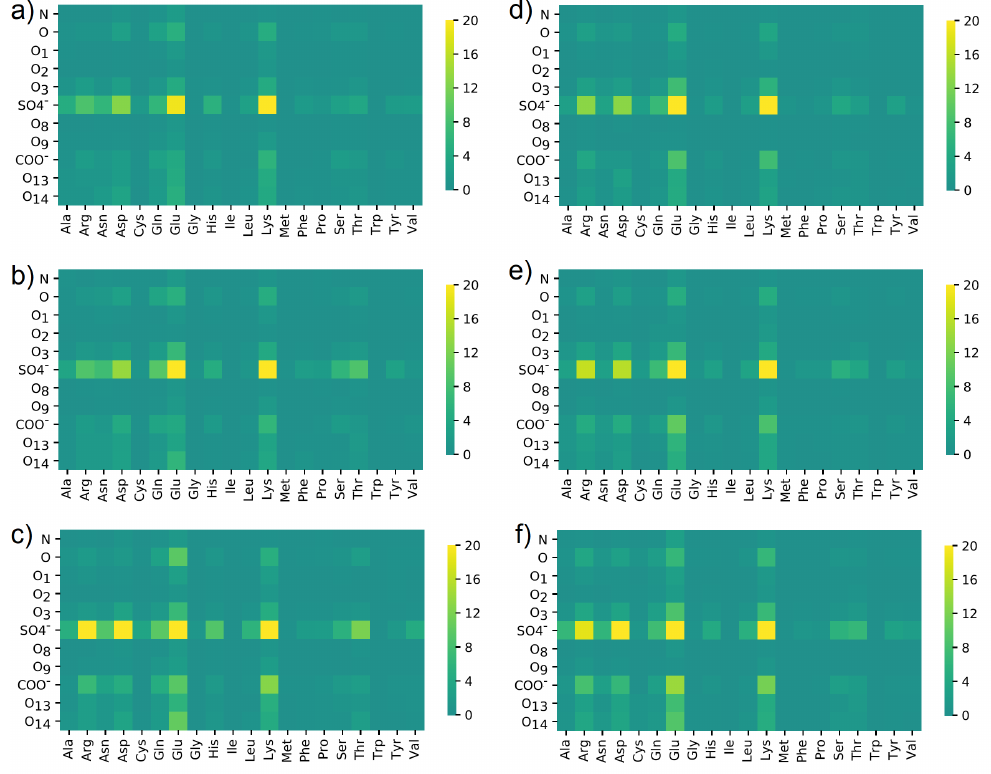
Figure 11. Water bridges distribution between different oxygen classes in ( a – c ) CS-6 and (( d – f ) CS-4 and different amino acids in HSA. Data were obtained in solutions containing: ( a , d ) NaCl; ( b , e ) CaCl 2 ; ( c , f ) MgCl 2 . The maps present a number of interactions. The denotation of the atoms and functional groups is presented in Figure